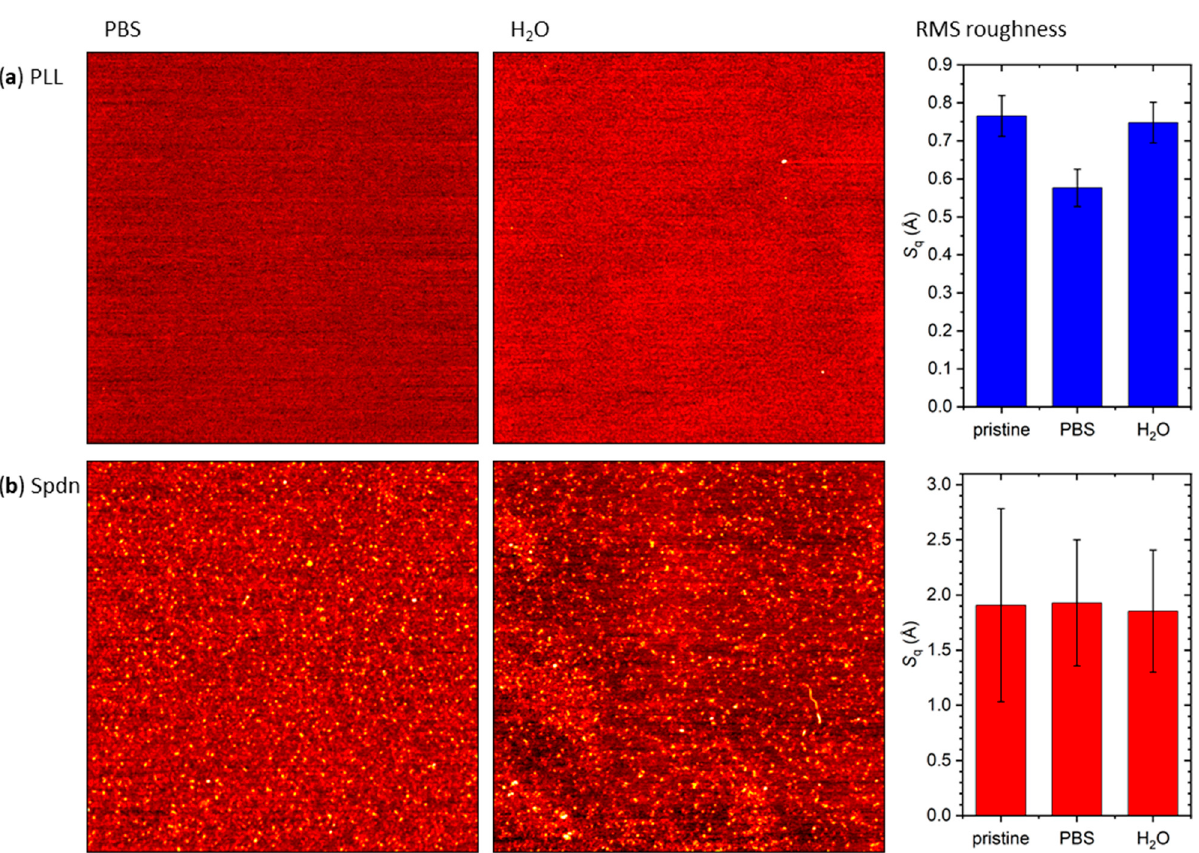
Figure 7. Representative AFM images of ( a ) PLL- and ( b ) Spdn-modified mica surfaces after incubation in PBS (left) and H 2 O (center). The right panels provide the RMS surface roughness values before and after incubation. The AFM images have a size of 3 × 3 µm² and a height scale of 1.5 nm. The RMS roughness values represent averages of three AFM images with the standard deviations as error bars.